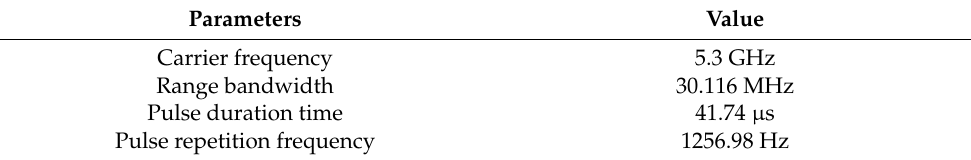
Table 4. The pulse number of processed SAR data is 1200. Table 4. Main radar parameters for